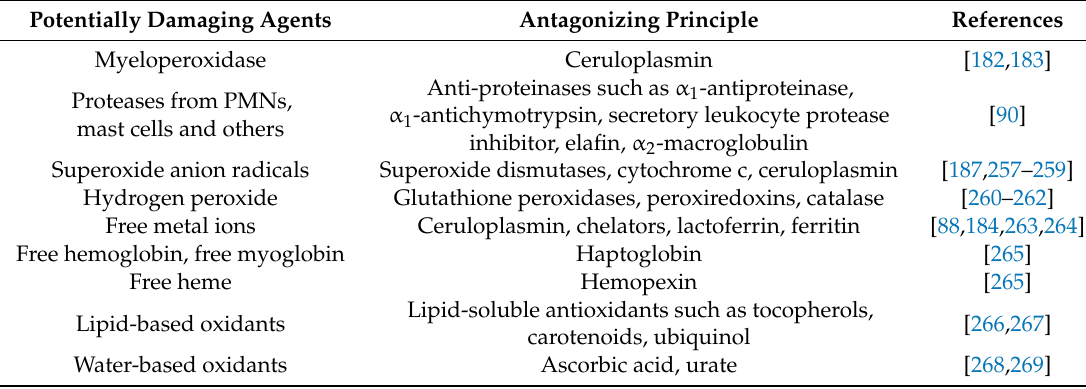
Table 3. Immediately acting protective mechanisms against frequently occurring damaging